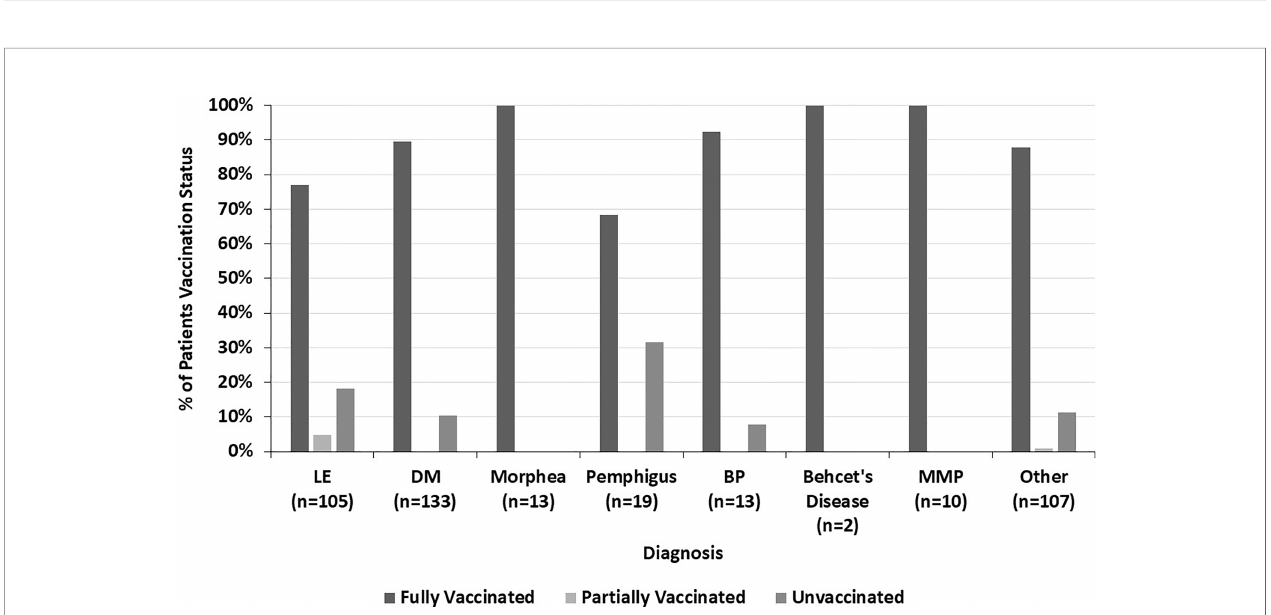
FIGURE 6 | The percent of patients who are fully vaccinated, partially vaccinated, and unvaccinated within each diagnosis, highlighting the variation across all diagnoses